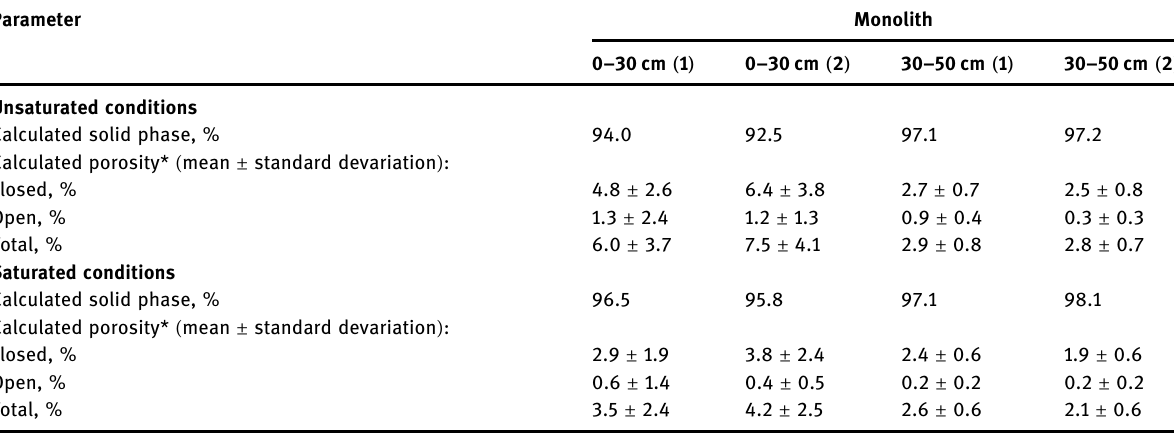
Table 2: 2D analysis of horizontal projections of tomographic images Parameter